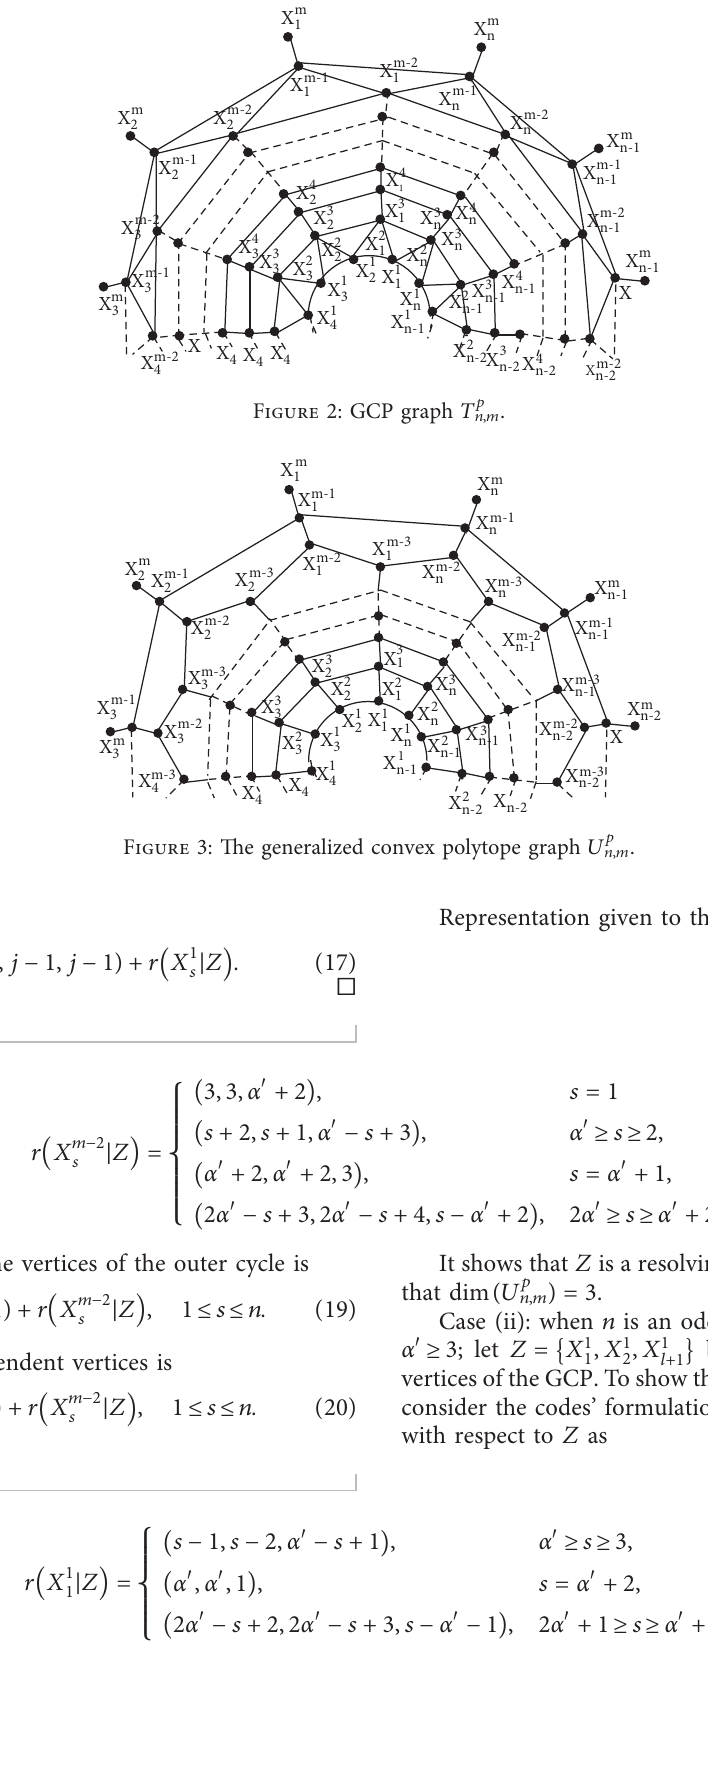
Figure 2: GCP graph T p